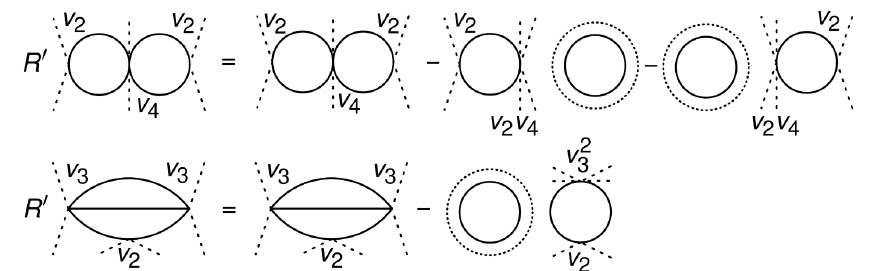
Figure 3 . R 0 -operation for the leading divergences.